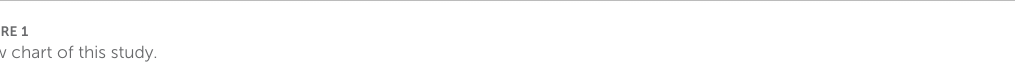
FIGURE1 Flow chart of this